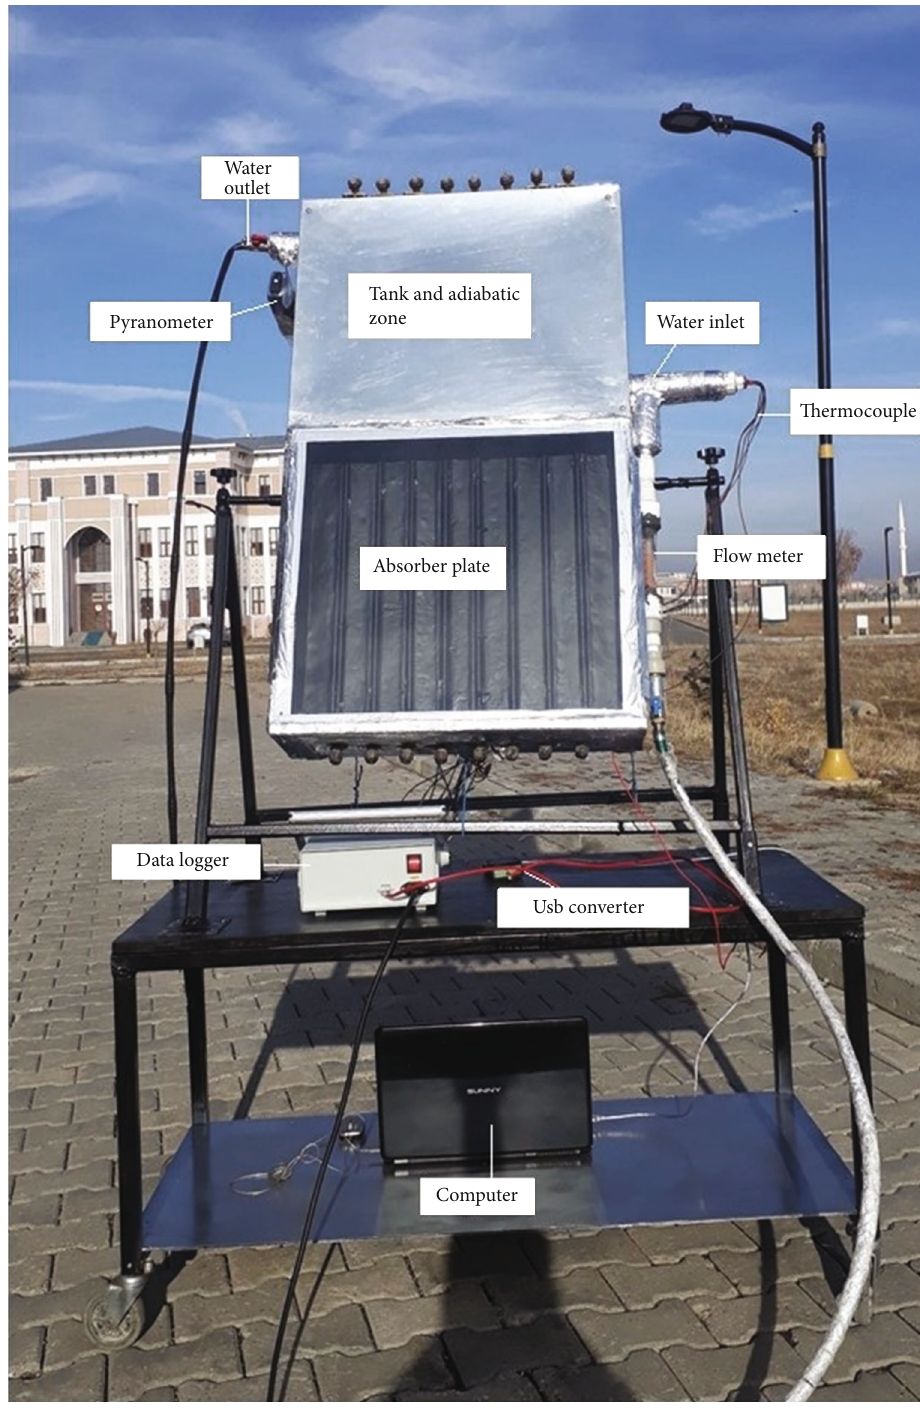
Figure 4: Experimental